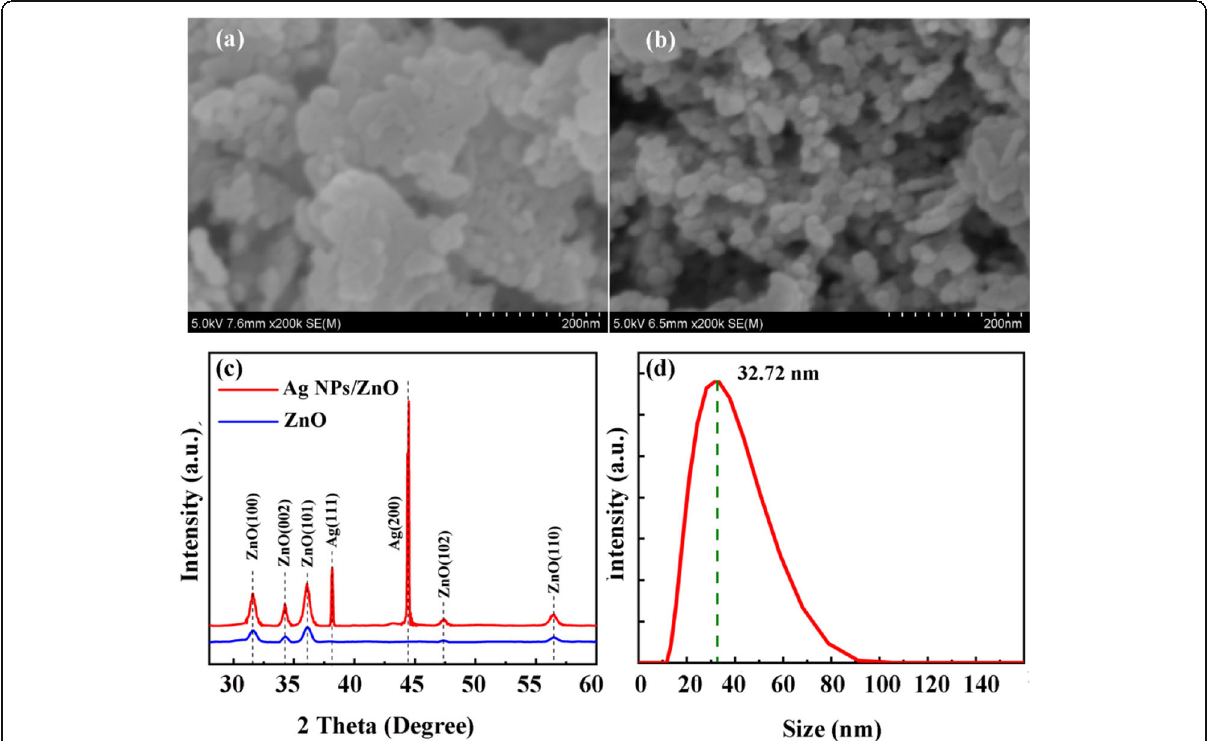
Fig. 1 The SEM image of a printed ZnO and b printed ZnO with printed Ag nanoparticles. c XRD patterns of ZnO film and without Ag NPs. d The size distribution of the Ag nanoparticles. Liu et al.